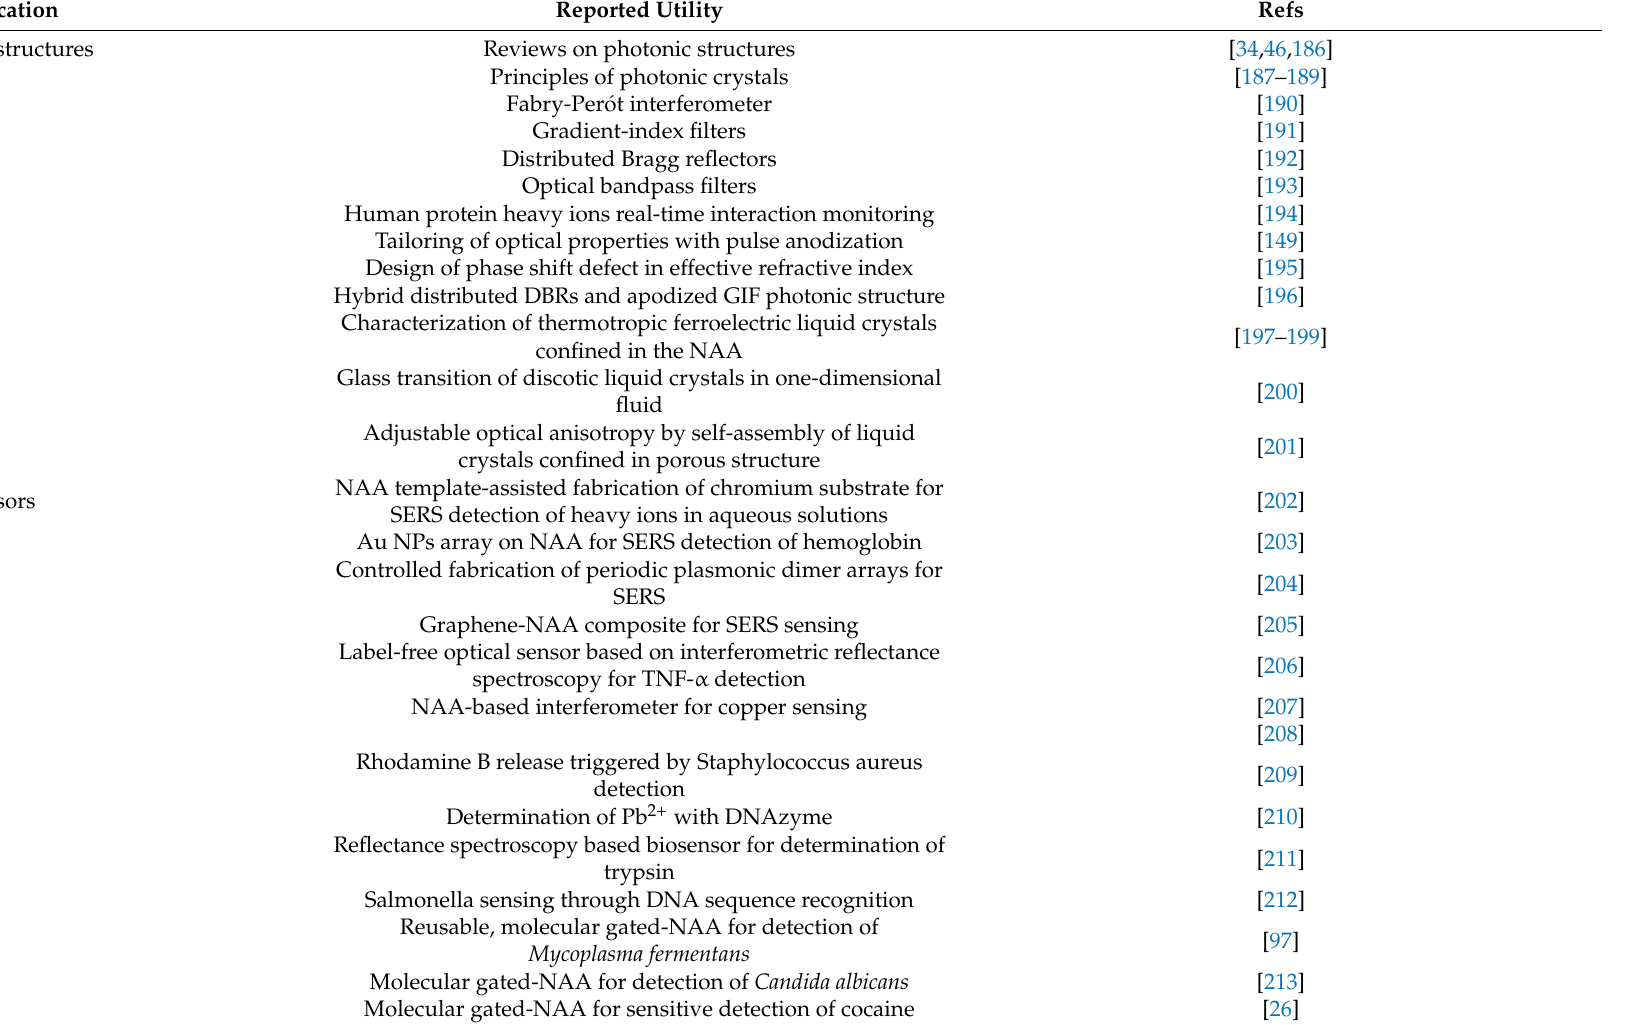
Table 2. Recently established applications of NAA-based